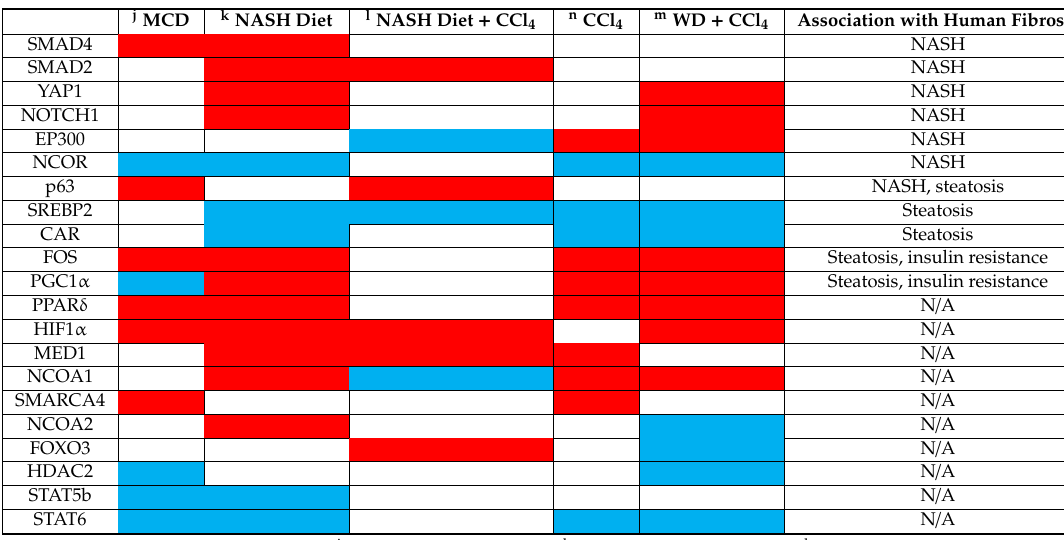
Table 3. IPA prediction of upstream regulators that were detected in the livers of mouse models of NASH but not in human NASH cohorts.